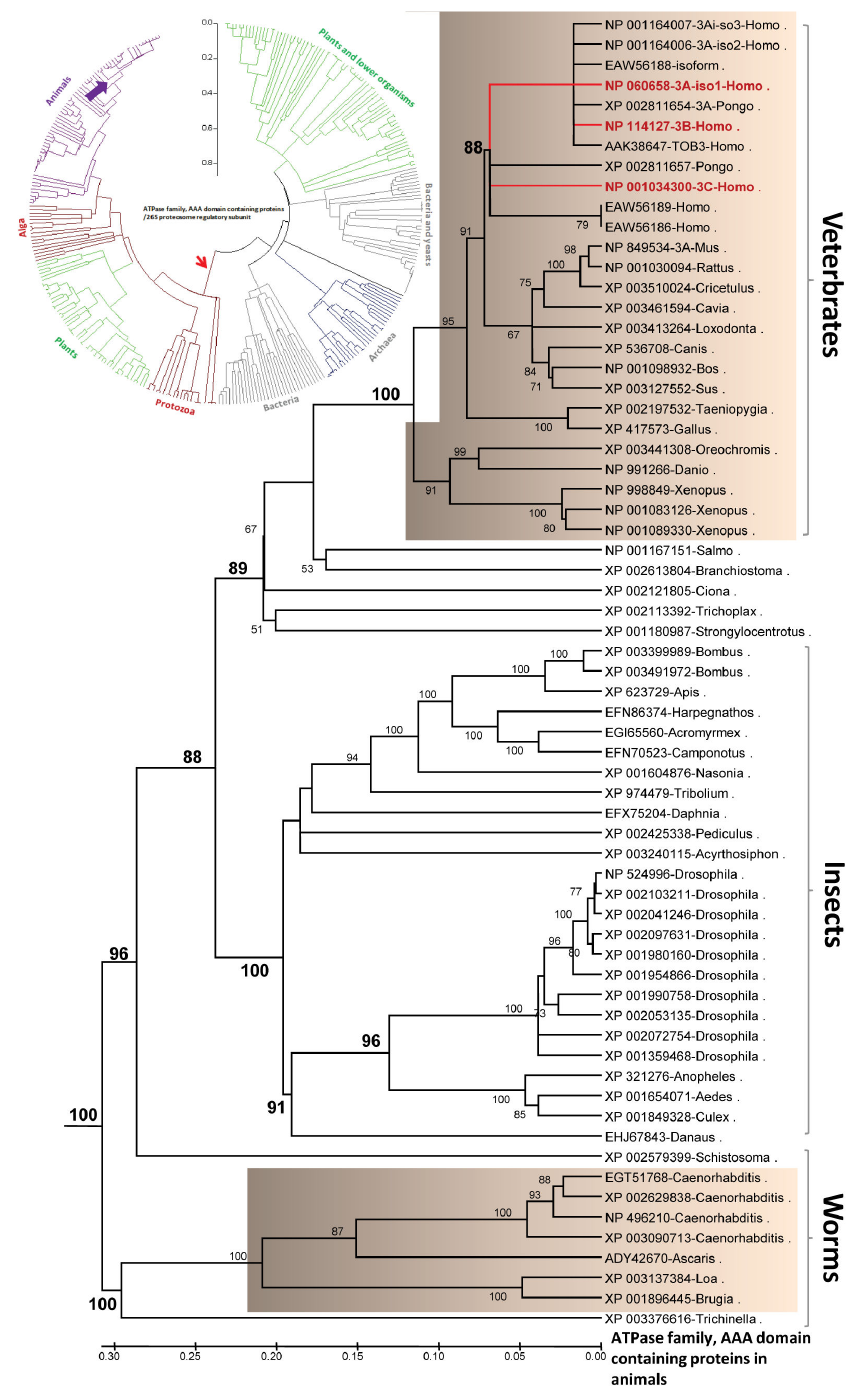
Figure 8. Phylogenetic analysis of ATAD3 sequences. The top 500 sequences related to the mammalian ATAD3 were used in this analysis as shown as a circle phylogenetic tree (inset). This analysis illustrated the evolutionary distribution of the orthologous ATAD3 genes throughout animals, plants, and protists (such as alga and protozoa), indicated by a red arrow. Animal ATAD3-related sequences were subtracted as shown in an NJ tree. ATAD3 genes from vertebrates, insects, and worms clustered as a phylogenetic branch with strong bootstrap support. Gene duplication events in humans and likely in other primates as well are highlighted by red bold letters as 3A, 3B, and 3C after each GenBank accession number. The bootstrap values greater than 50% are indicated. doi: 10.1371/journal.pone.0076701.g008 PLOS ONE |